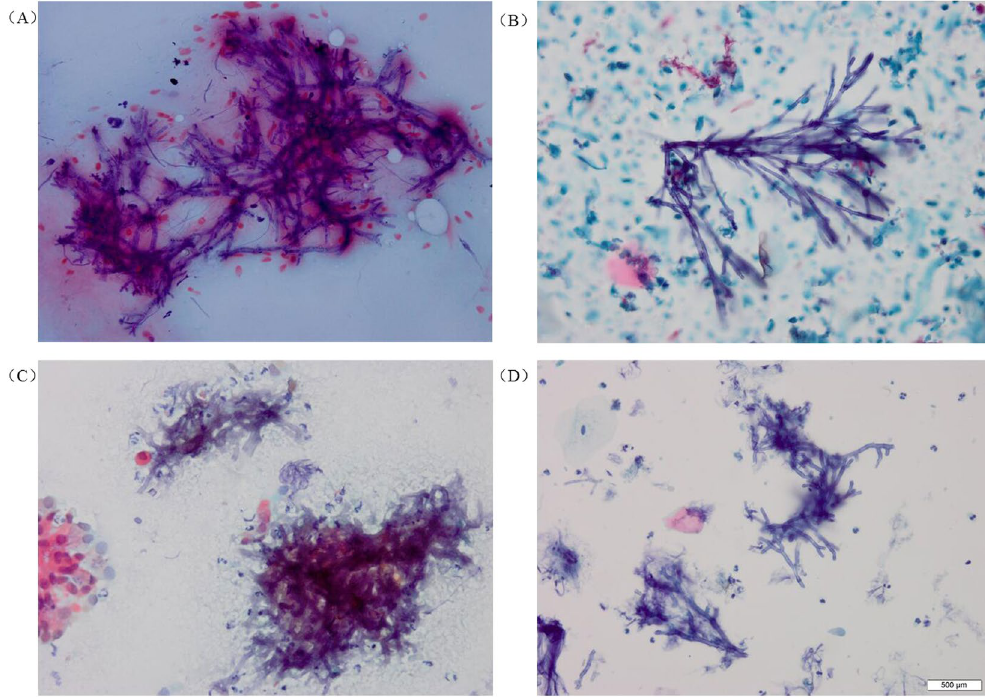
Figure 1. Cytomorphology of Aspergillus in sputum and bronchial brushing samples processed using the SurePath LCT platform or conventional cytopathology, followed by Papanicolaou’s staining. Typical cytological features of Aspergillus filaments included filament separation, constant filament diameter and parallel filament edges, with dichotomous branching at acute angles. Samples were stained with Papanicolaou’s stain. Magnification, 400X. ( A ) Conventional cytopathology on sputum samples; ( B ) LCT on sputum samples; ( C ) Conventional cytopathology on bronchial brushing samples; ( D ) LCT on bronchial brushing samples; LCT: Liquid-based